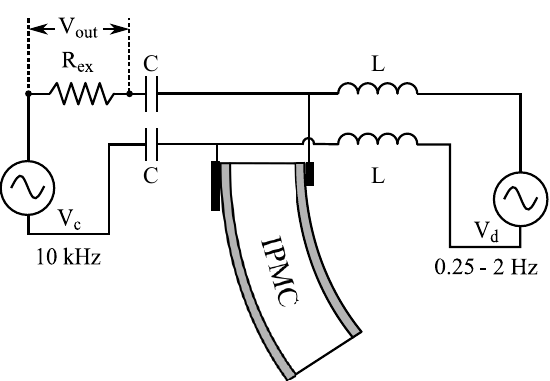
Figure 18. Sensing IPMC deformations during actuation by measuring the changes in through-IPMC impedance [143] and IPMC clamp contact impedance [12]. While the former method uses symmetric IPMC clamp, the latter relies on asymmetric clamping electrodes design (as illustrated in the figure) that increases impedance sensitivity to deformations. Both methods measure the impedance using a high-frequency signal that is modulated with actuation voltage.